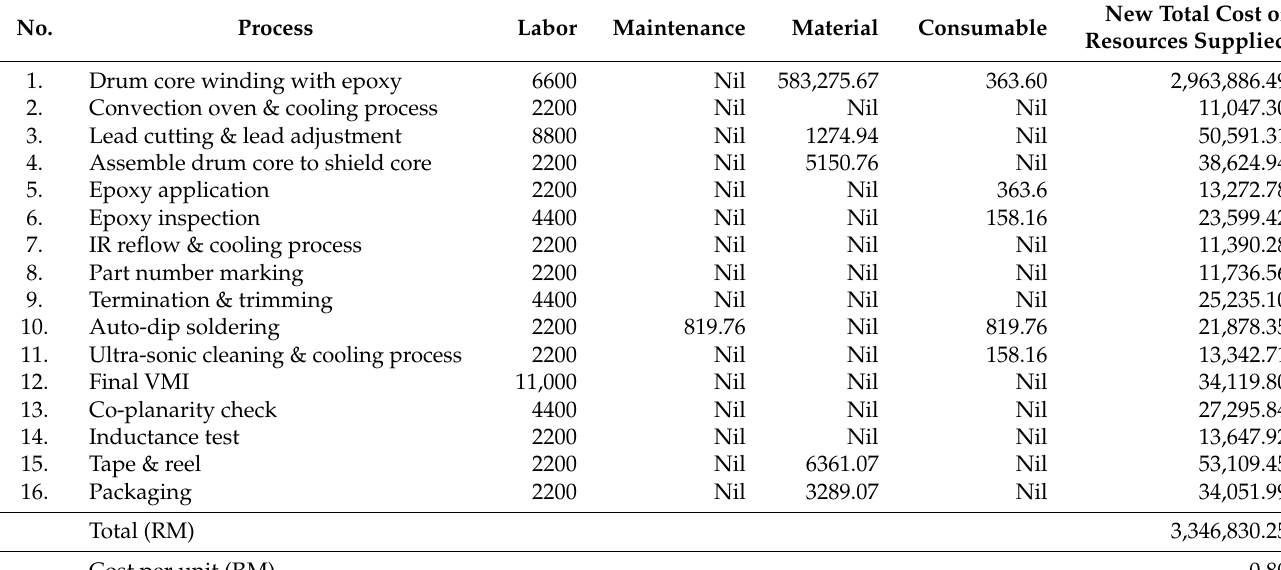
Table 6. Costing structure under integration D.